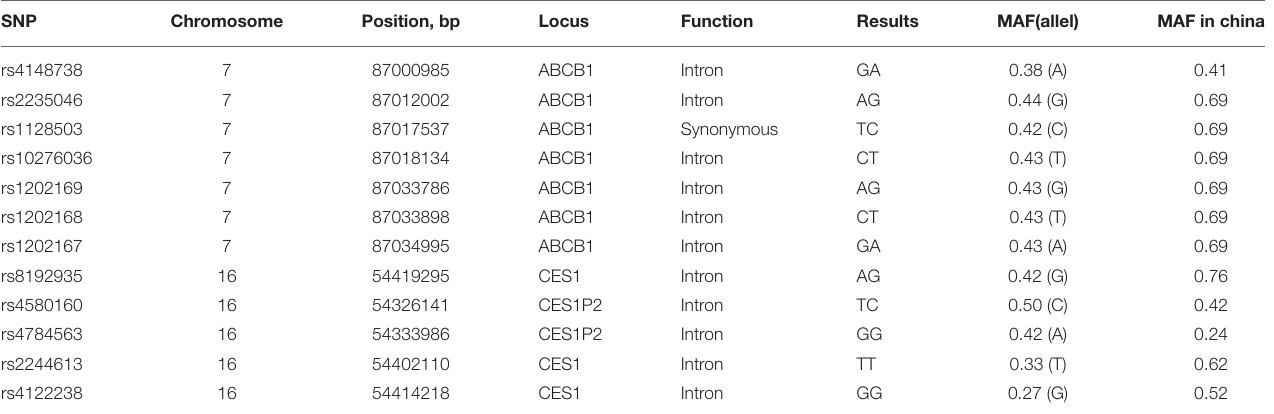
TABLE 4 | The results of ABCB1 and CES1